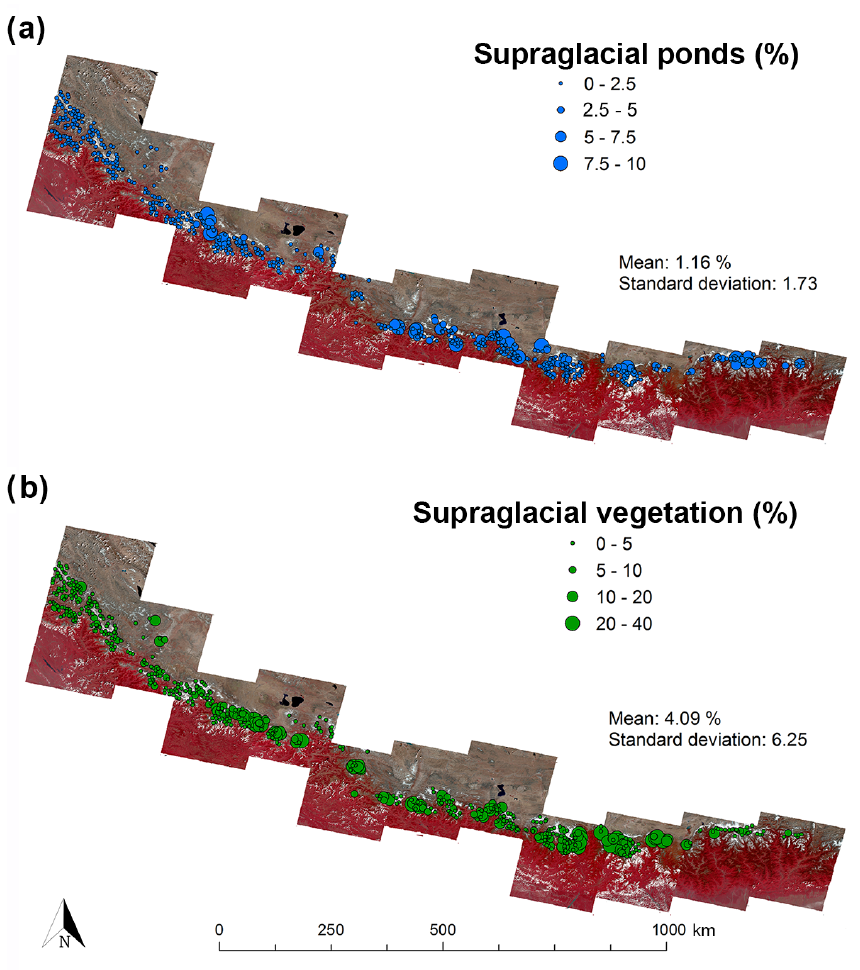
Figure 11. Distribution of (a) supraglacial pond coverage and (b) supraglacial vegetation, expressed as percent of each debris-covered area on a glacier-by-glacier basis for the 408 sampled